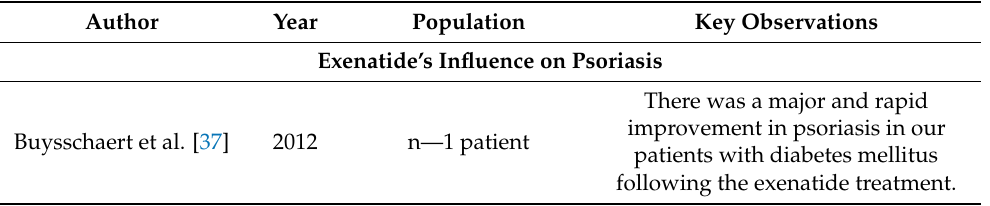
Table 16. Summary of the studies on exenatide’s influence on